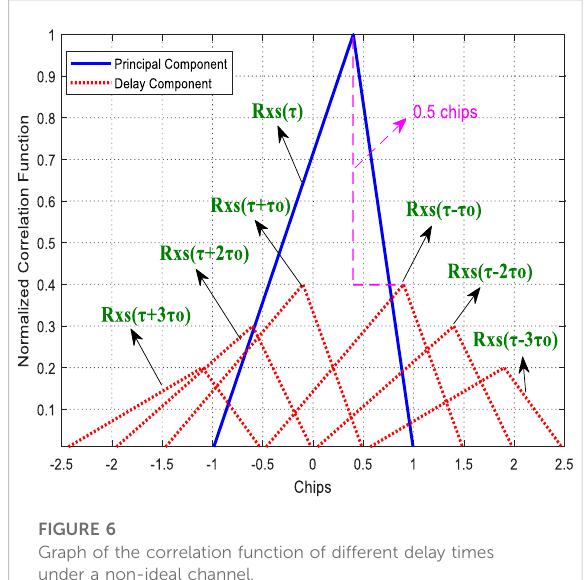
FIGURE 6 Graph of the correlation function of different delay times under a non-ideal